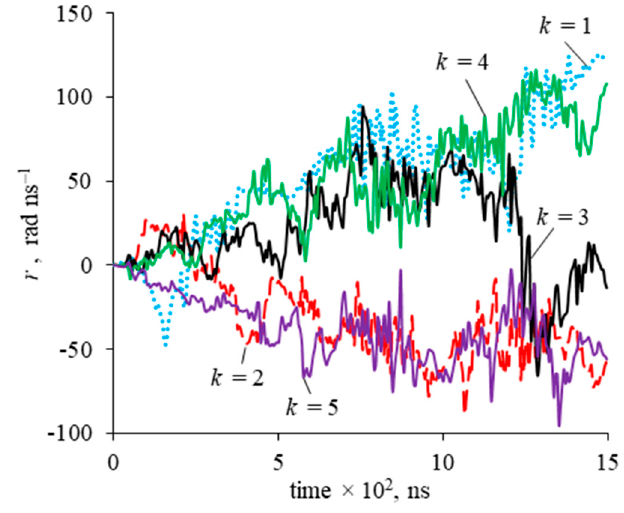
Figure 8. Time dependence of the ζ k -components of angular velocities at S = 5.